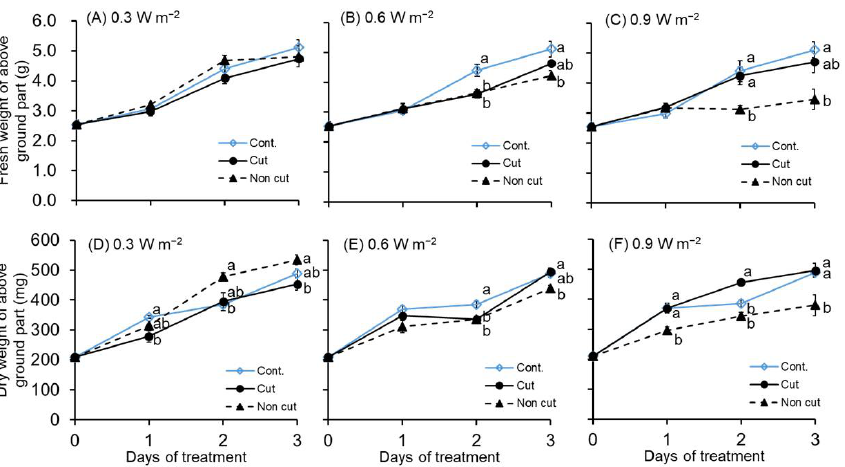
Figure 1. Effects of ultraviolet (UV) irradiation with or without 300 nm short-cut filters on the fresh weight ( A – C ) and dry weight ( D – F ) aboveground parts for 0–3 days of treatment. The UV irradiation intensity was set at 0.3, 0.6, and 0.9 W m −2 . The vertical bars indicate SE ( n = 3–6). Different letters indicate significant differences among the treatments in each UV irradiation intensity at p < 0.05 by Tukey–Kramer’s